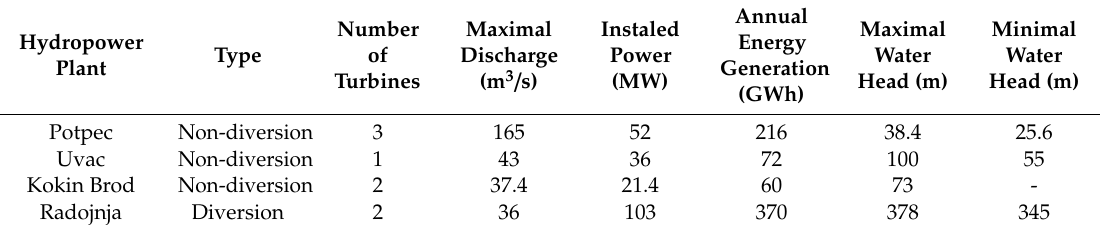
Table 2. The characteristics of hydropower plants in the Lim water system.